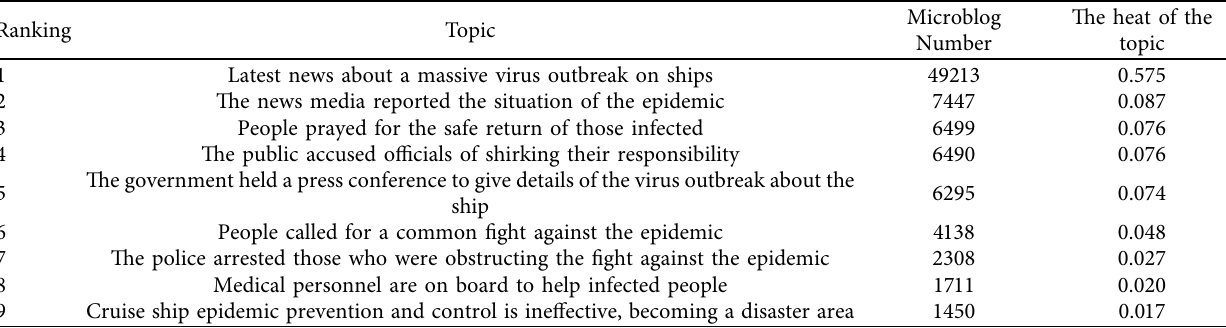
Table 3: Comparison of the number of posts and heat on various topics in the public health